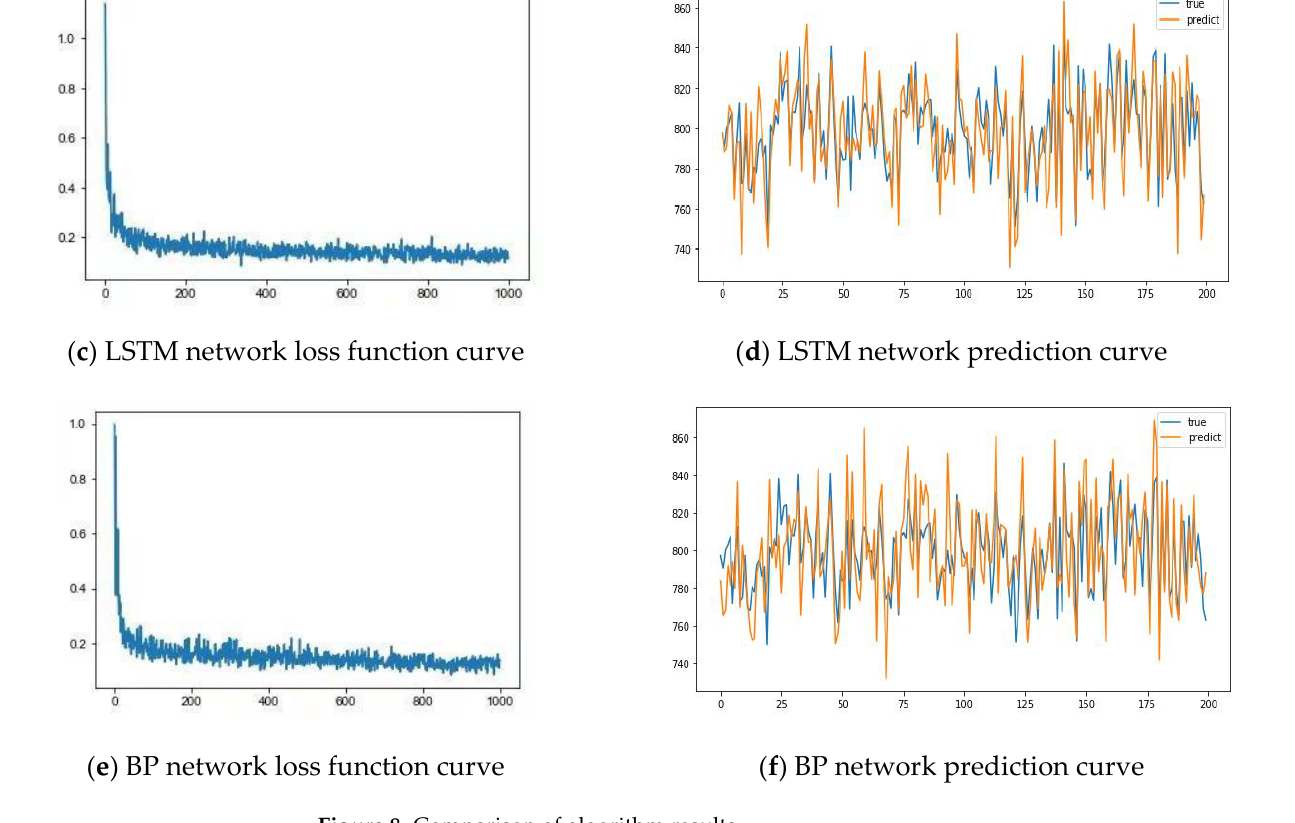
Figure 8. Comparison of algorithm results. The prediction results of 10 randomly selected groups of prediction models are shown in Table 8 below. Table 8. Model prediction results.